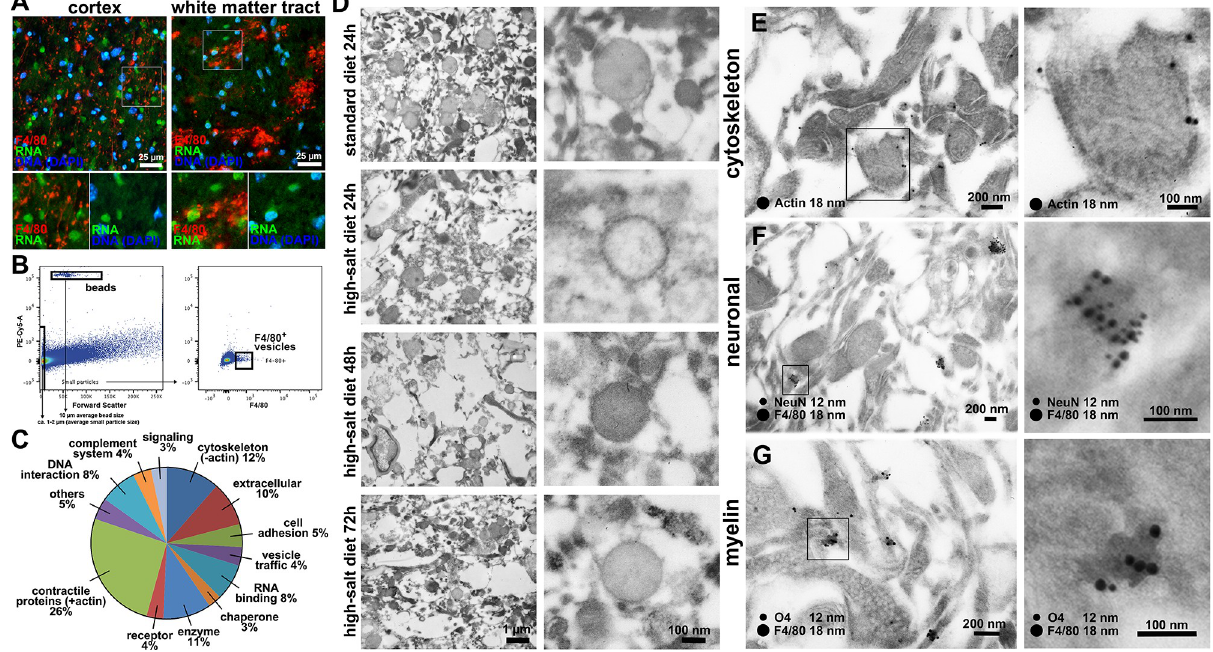
Fig 4. Identification of migrasome components. (A) Co-staining of F4/80 and RNA did not show RNA-signaling within the migrasome either in cerebral cortex or white matter tracts. (B) Gating strategy: All particles smaller than 2 μ m in size compared to the added beads were sorted for F4/80 + -signal. Quantification was performed by comparing the number of beads with the number of F4/80-positive particles. Quantification revealed a higher amount of F4/80 + -vesicles in high-salt diet group when compared to the standard diet. (C) Proteomic analyses demonstrated that the migrasome was mainly composed of contractile proteins actin and myosin, cytoskeleton and annexin proteins, which were previously described to be involved in trafficking and organization of vesicles [25]. (D) Electron microscopy confirmed the typical morphological characteristics of the migrasome on ultrastructural level. Time course analyses revealed an increasing degree of extracellular tissue damage within the first 72 h after stroke. Vesicle close- ups reveal cup-like structures carrying spherical structures in all investigated time-points and treatments. (E) Immunogold-staining shows actin-postive signals especially in the outer layer of the vesicle-like structures. (F) Co-staining of F4/80 and NeuN confirms fluorescence microscopic observations and shows a distinct clustering of F4/80 and NeuN-signals in small vesicle-like structures. (G) F4/80 and O4-staining also reveals a solid co-localization in node-like